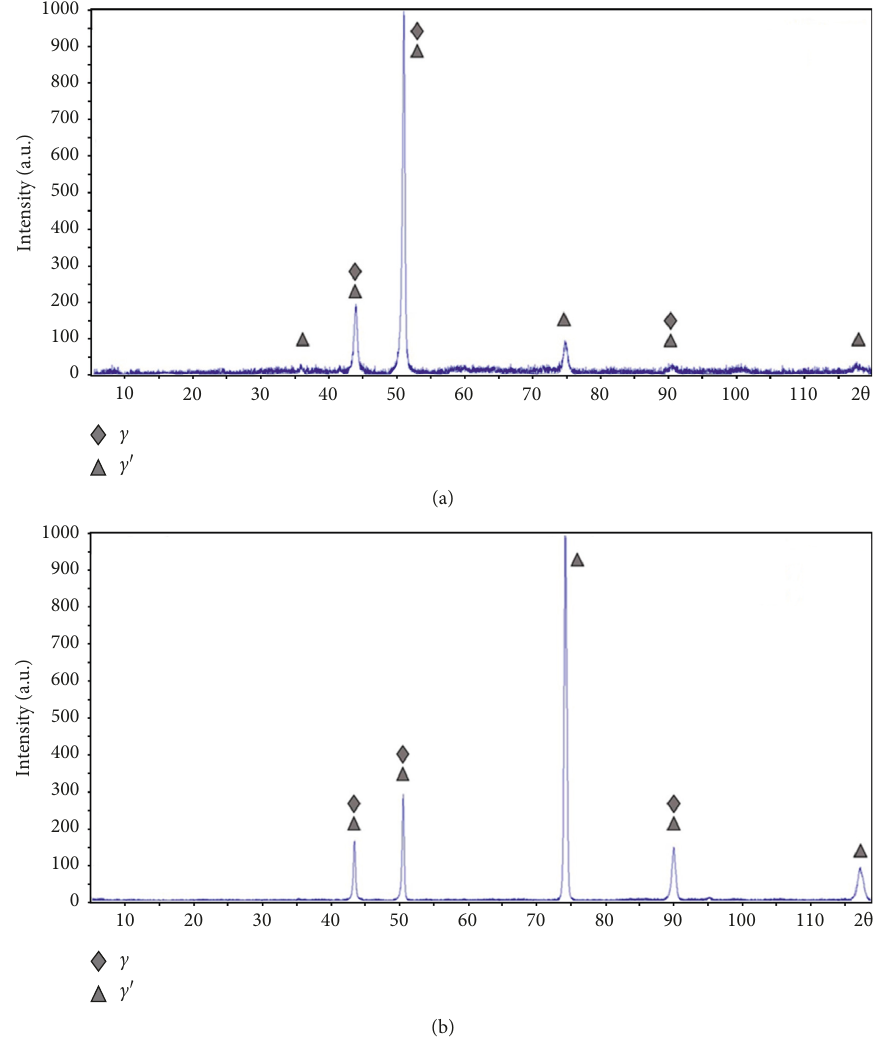
Figure 13: XRD patterns of the IN-792 superalloy with the following heat treatment conditions: (a) solution treating and (b) complete heat treatment.